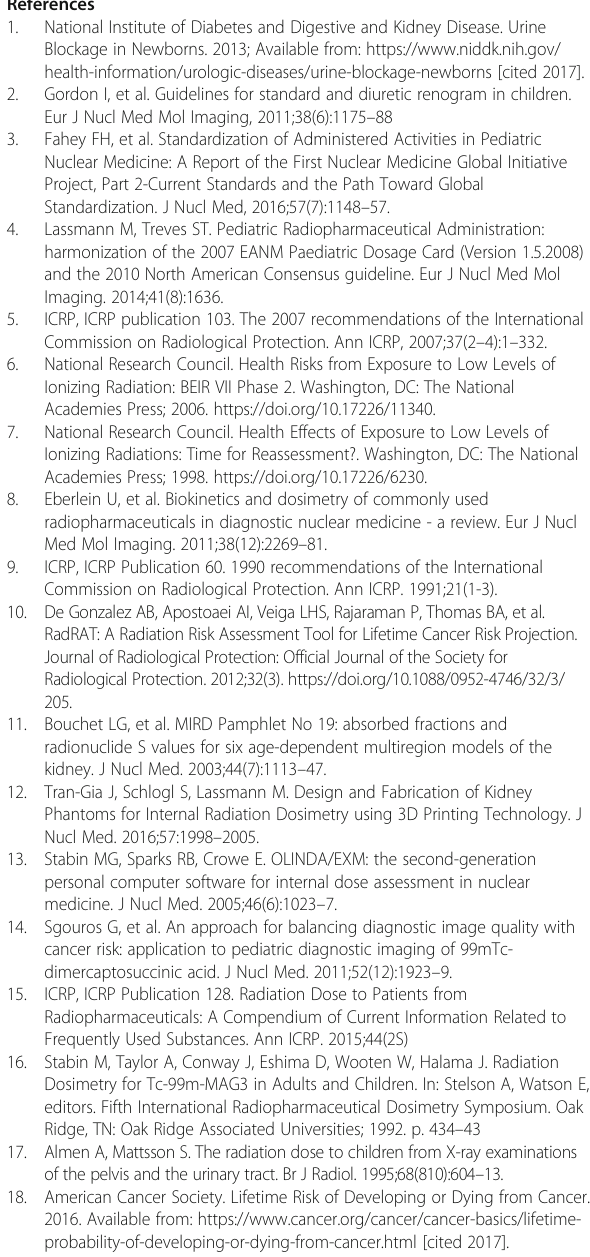
Additional file 1: Table S1. Patient-specific organ sizes classified per age groups (newborns and 1-year-olds). Table S2. Demographics clustered by age groups with patients ’ information of age, gender, weight, body size, and injected activity. Table S3. The values for Patient organ-specific mean absorbed dose coefficients. Table S4. Mean organ-specific absorbed doses and respective estimated excess lifetime risk per cancer site (chances in 100,000 persons) for newborns (1.6 – 11.0 months) and 1-year-olds (13.0 – 20.0 months) clustered per gender. (PDF 1213